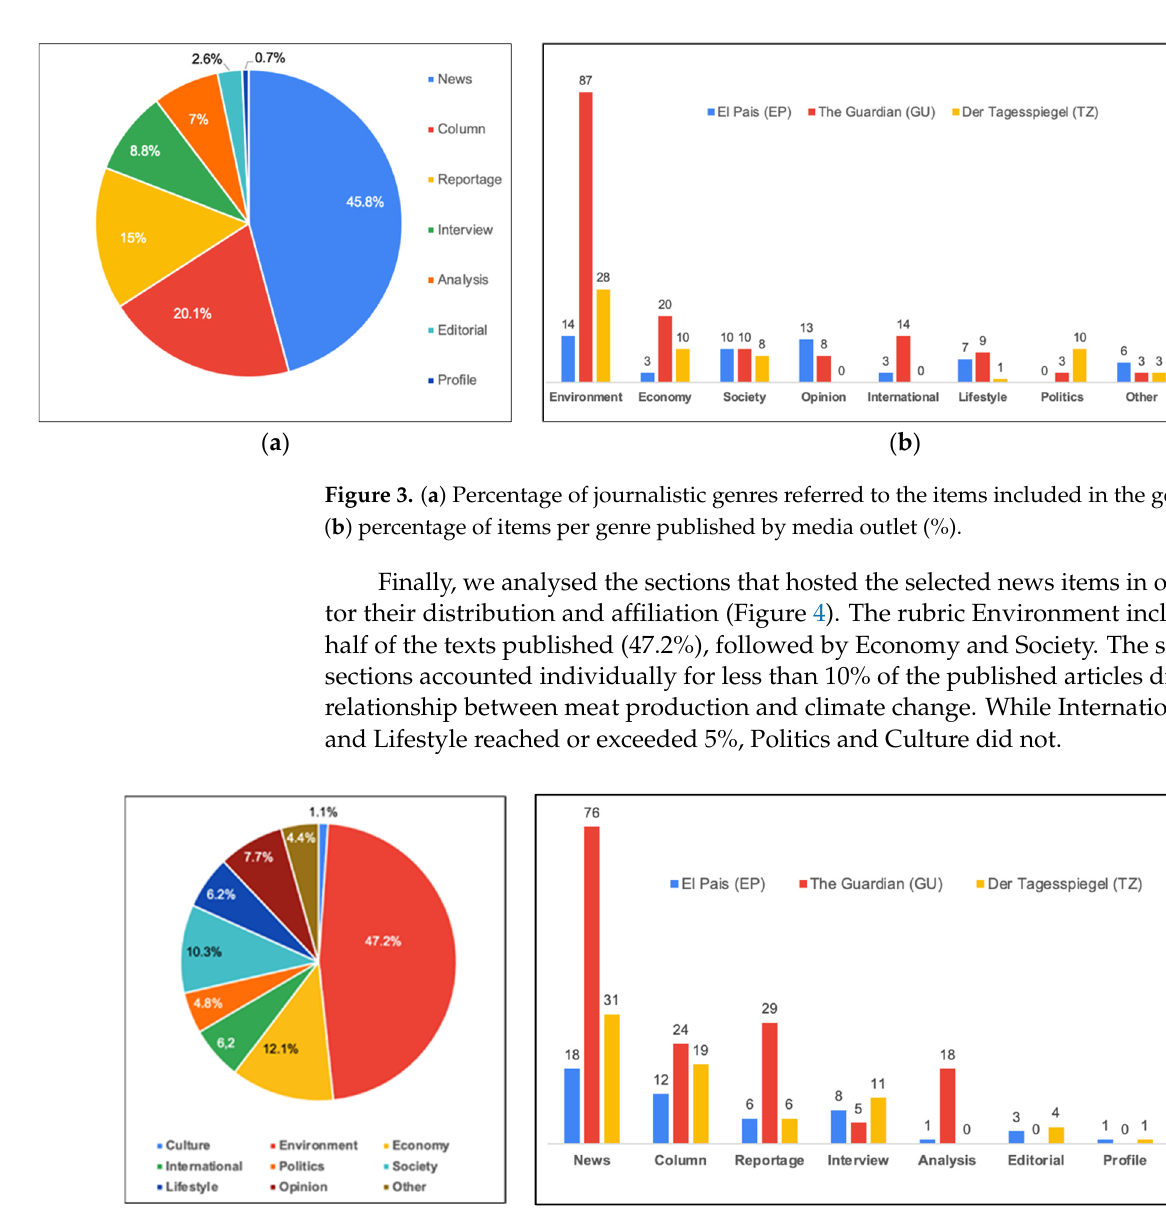
( b ) Figure 5. ( a ) Percentage of news by group of frames included in the general sample; ( b ) percentage of items published by media outlet in each big frame (%). In the same vein, Table 4 furthers our understanding of the specific strategies (frames) employed by the media. In the whole sample, solution frames such as sustainable farming and animal welfare, systemic change and plant-based food and insects were the most mentioned. The Guardian gave priority to these frames, which led to these results. Likewise, Der Tagesspiegel mostly used a perspective centred on sustainable livestock farming and animal welfare (n = 22). Again, these were contrary to the pattern of El País . The Spanish newspaper published a similar number of items in diagnosis frames and so- lutions frames.